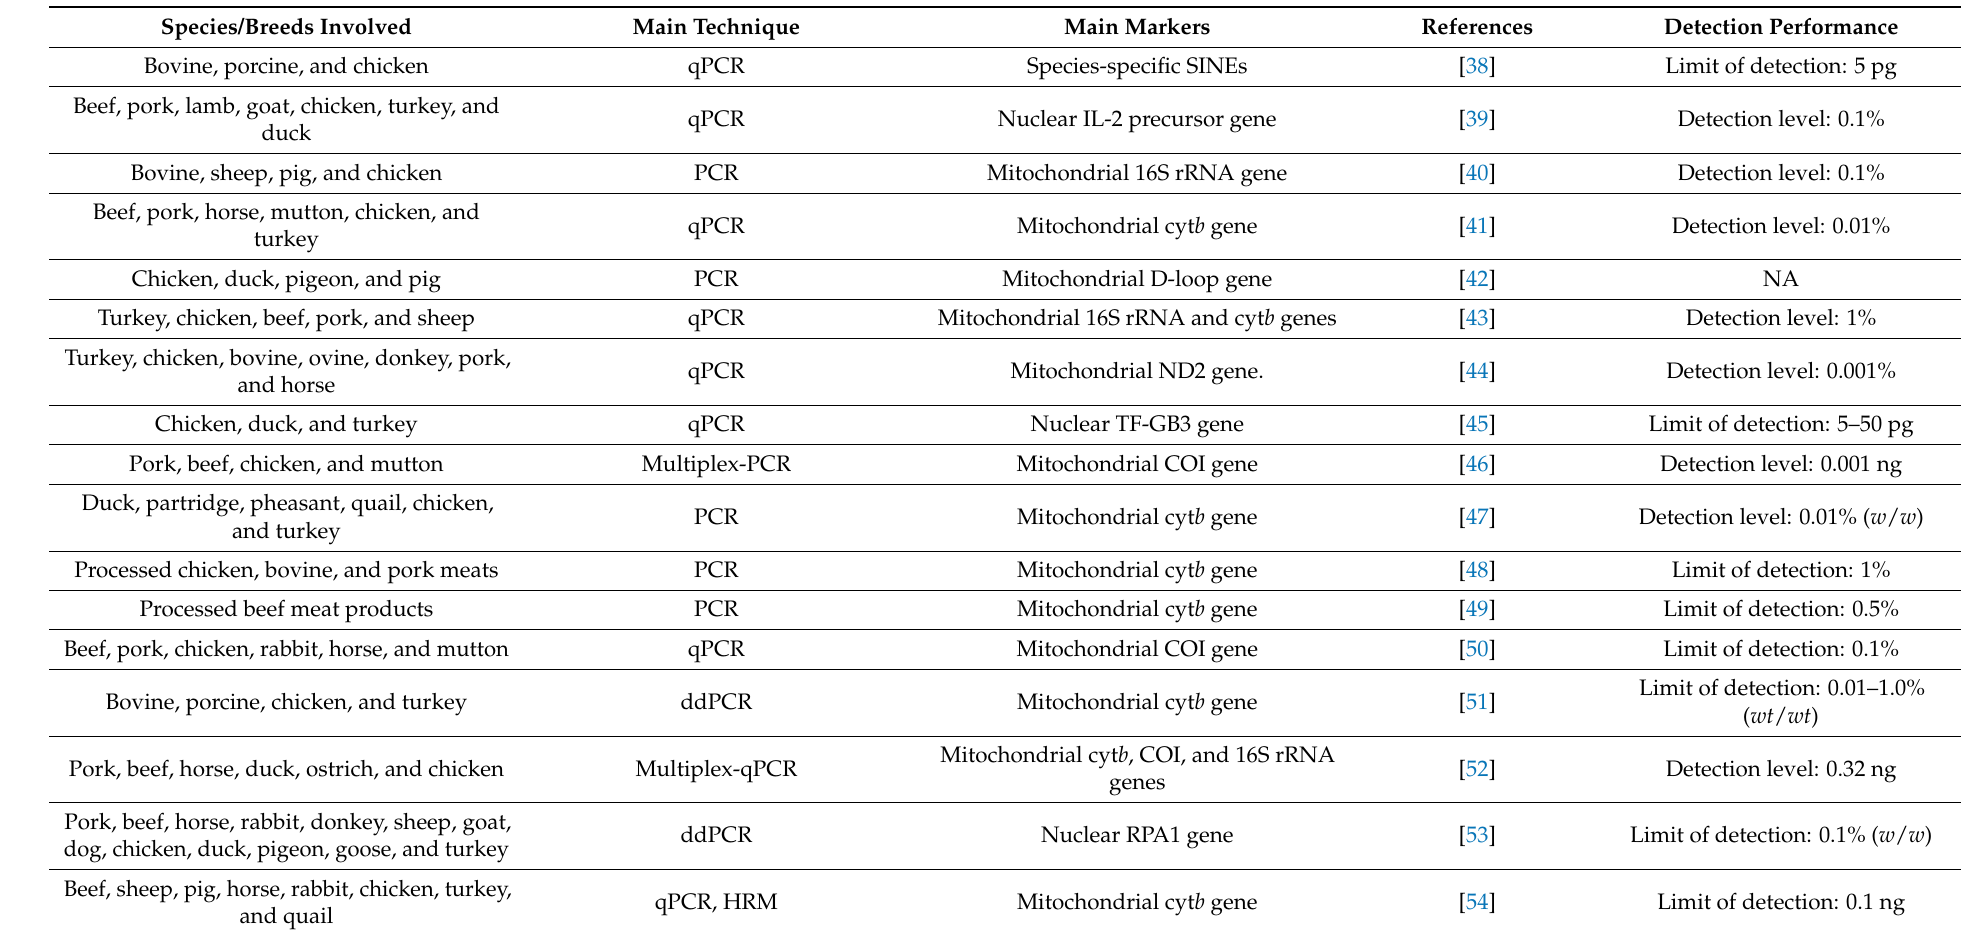
Table 1. Summary of classical DNA-based techniques in the application of detection and authentication of chicken in meat and meat products. Type of samples and performance (limit of detection and discriminating accuracy) are included when